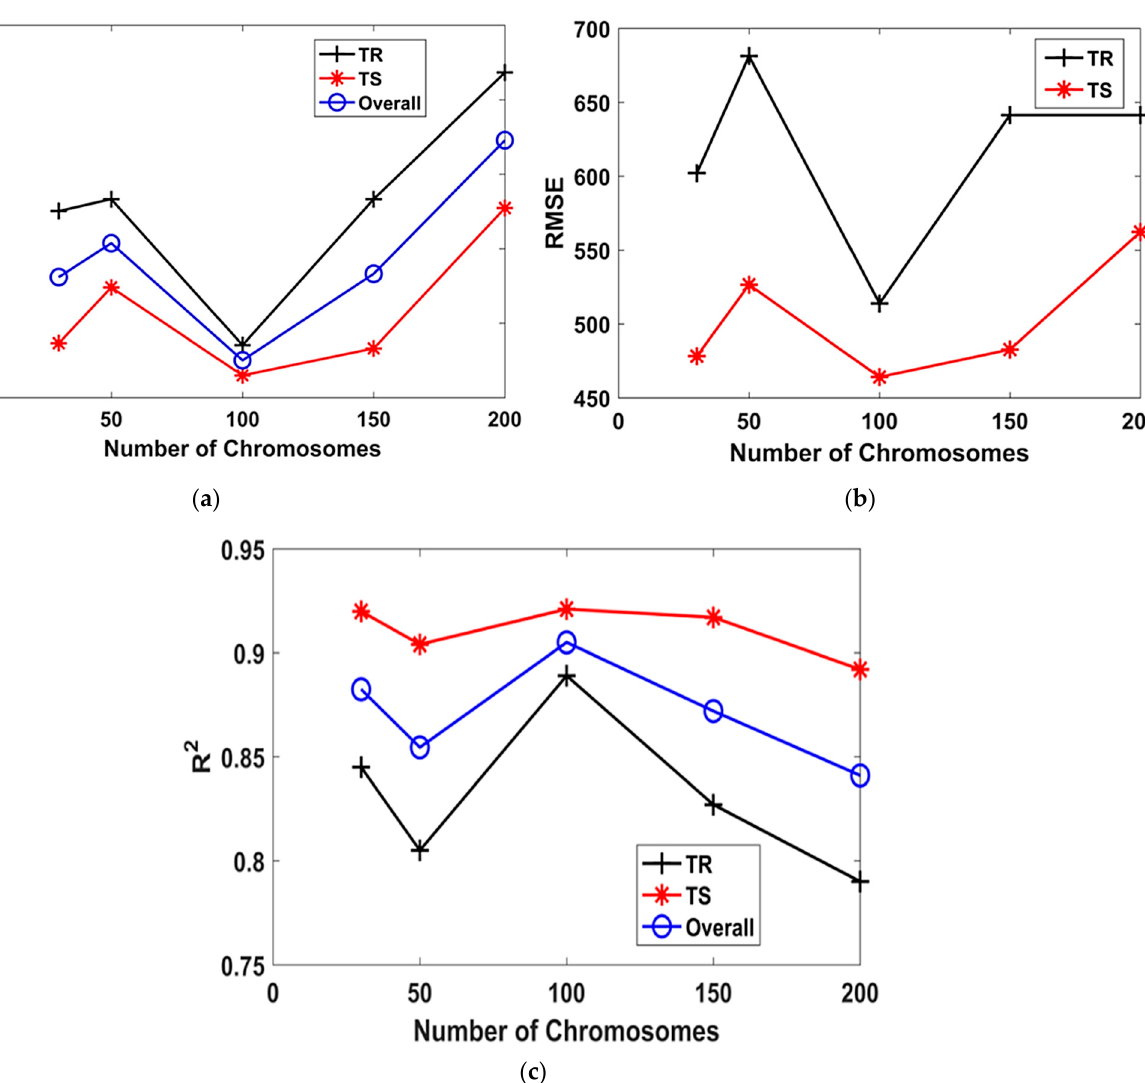
Figure 3. Effect of number of chromosomes on the performance of models. ( a ) MAE, ( b ) RMSE, ( c ) R 2 .